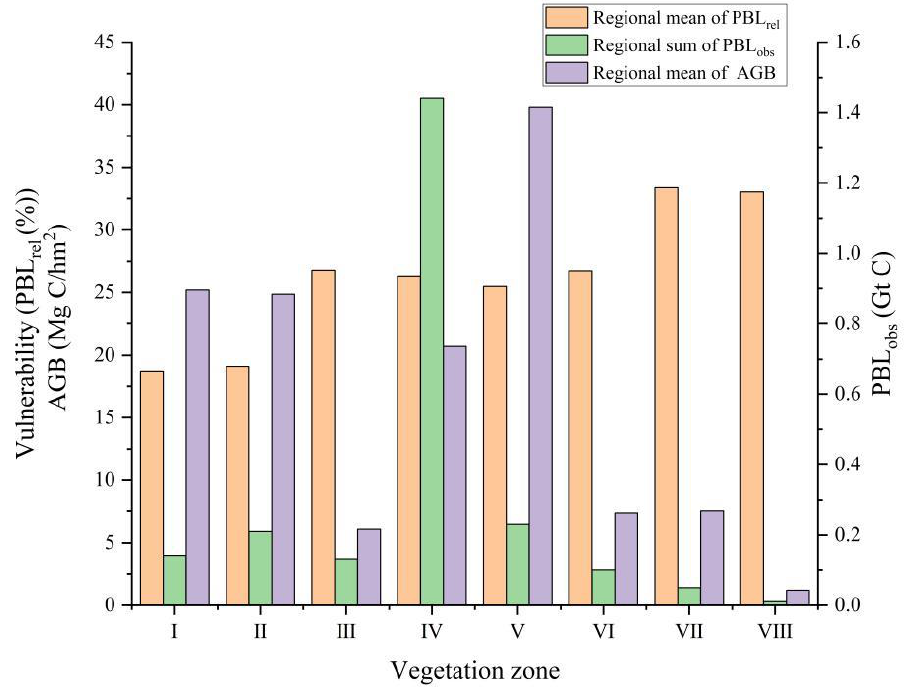
Figure 5. Bar plots of the potential relative AGB loss (PBL rel ), the potential absolute AGB loss (PBL abs ) and the regional average AGB in different vegetation zones. Figure 6 indicated the spatial distribution of the forest vulnerability trend from 2001 to 2020. In all, 89% of vegetated grids in China exhibited a nonsignificant trend. A significant decrease in forest vulnerability occurred in zone I and zone II (overall 7% of the forest vegetated grids), and a significant increase (4% of the forest vegetated grids) was mainly distributed in vegetation zone IV and zone